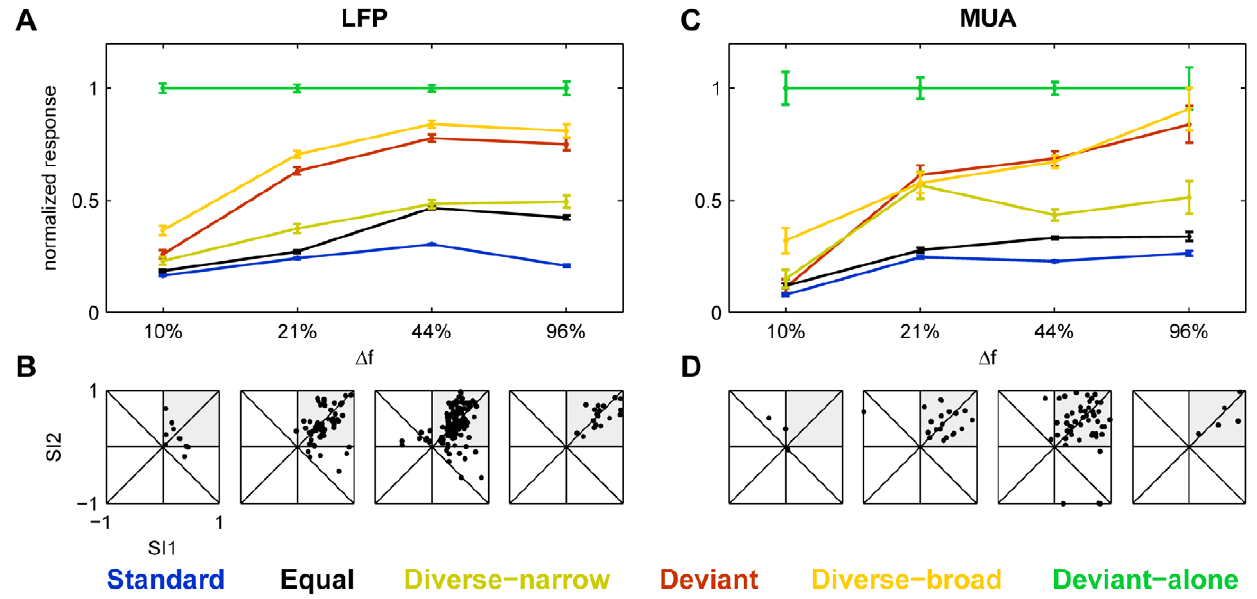
Figure 7. Summary of the responses at all D f. A. The population average of normalized LFP responses to the six conditions for four different values of D f. B. Scatter plots of SI2 vs. SI1 for LFP data from all recording sites as a function of D f. C,D. Same as A,B, but for MUA data. The scatter plots of SI2 vs. SI1 at D f=44% are those appearing in Fig. 2A, and have been replotted here as well for completeness.